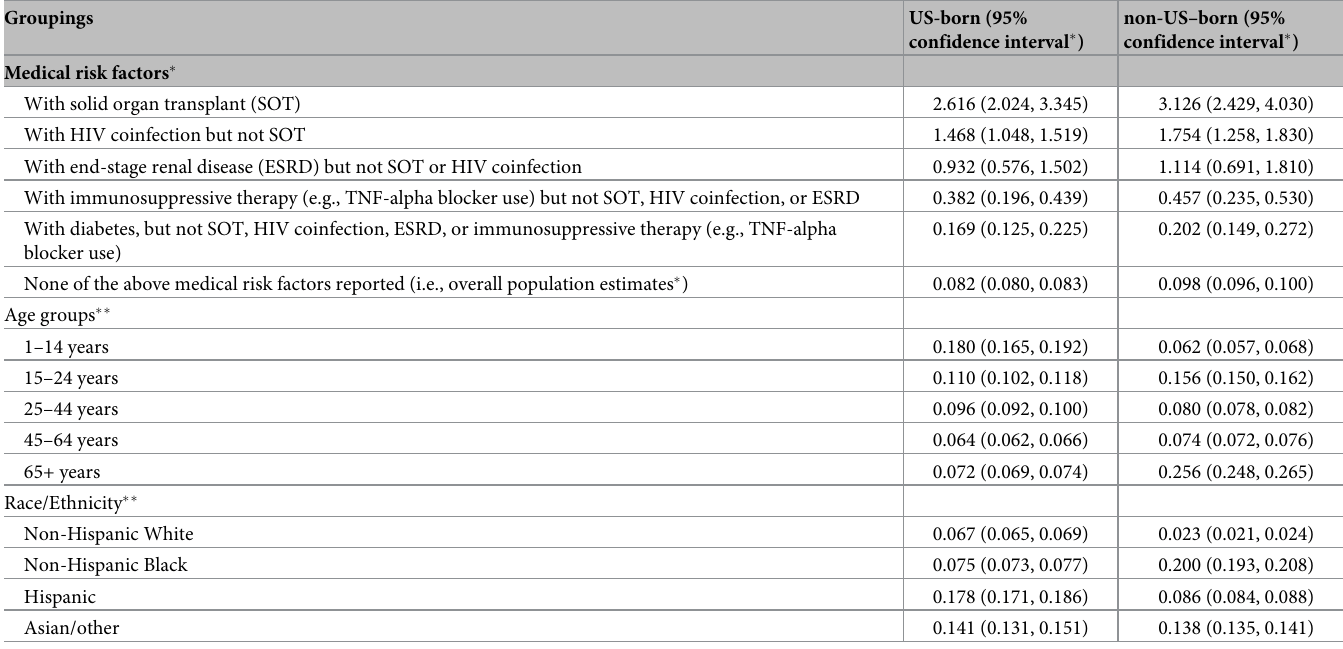
Table 1. Back-calculation model inputs: Estimated reactivation rates (per 100 person-years) by medical risk factors and demographic characteristics, stratified by nativity (U.S. birth or non-US birth).